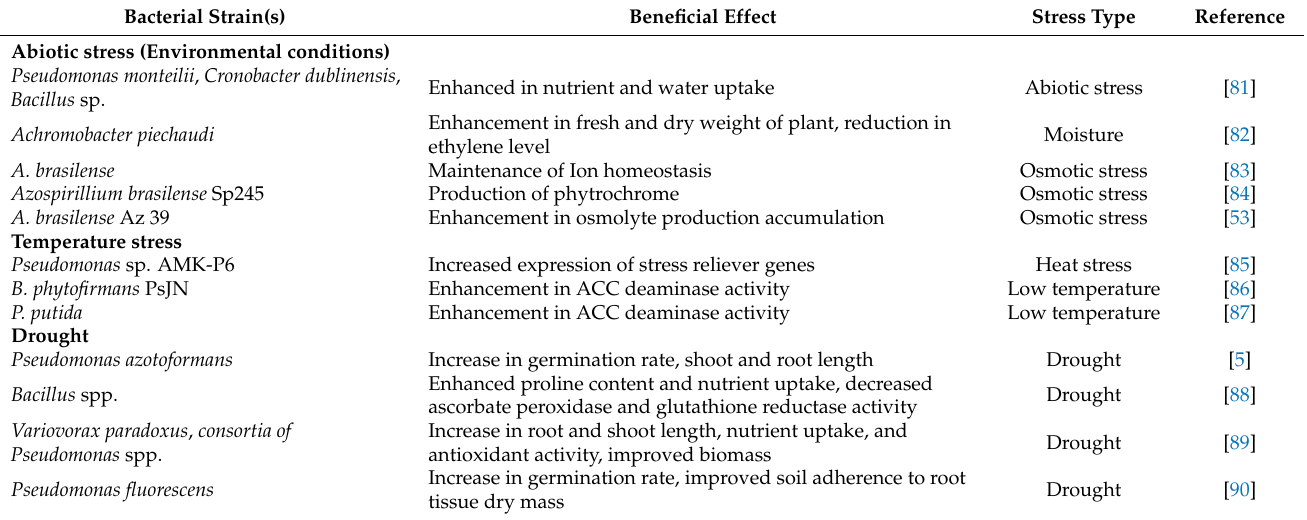
Table 1. PGPR mediated promotion of plant growth via, alleviation of abiotic